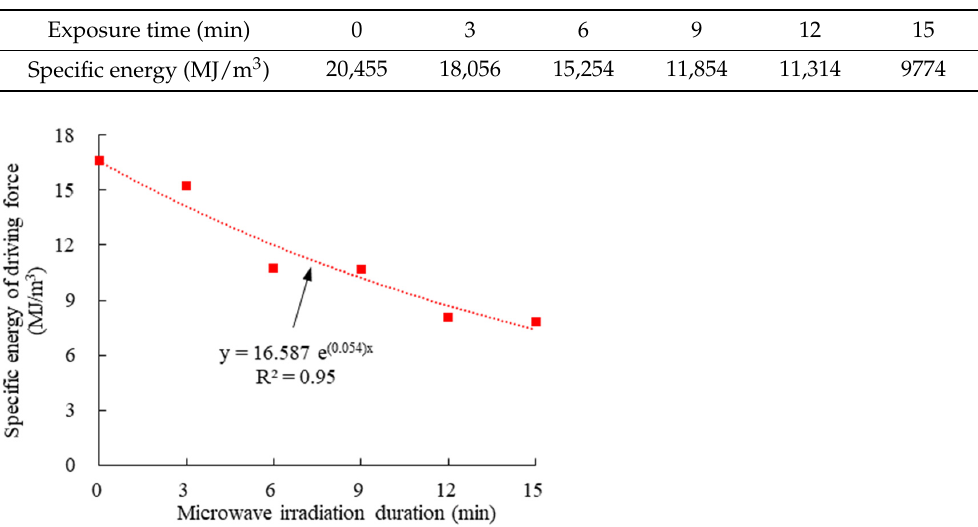
Figure 15. Relationship between the specific energy of the driving force and the microwave exposure time .